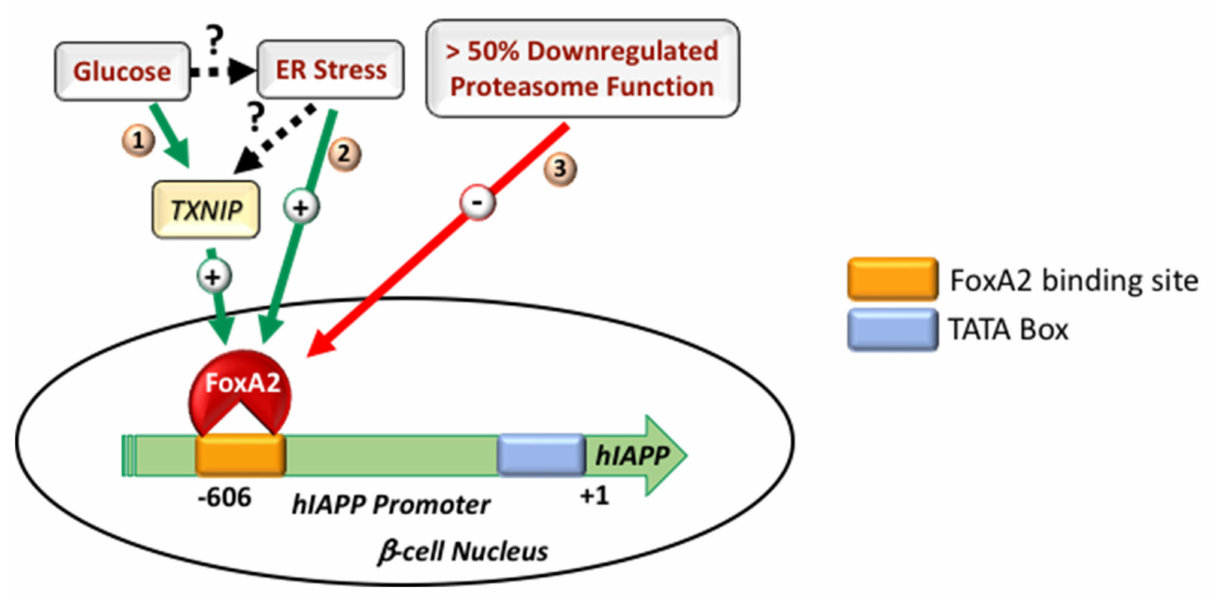
Figure 2. Regulatory mechanisms driving IAPP transcription in normal and stressed pancreatic β -cells. ( 1 ) High glucose induces expression of the major glucose regulated gene TXNIP, which, in turn, upregulates IAPP transcription by increasing the expression and promoter binding of IAPP specific transcription factor FoxA2 in the β -cell. ( 2 ) Similarly, ER stress upregulates IAPP transcription in β -cells by increasing IAPP promoter’s occupancy for transcription factor FoxA2, for which the binding of could be TXNIP-dependent or independent. ( 3 ) Severe inhibition of proteasome function and associated protein stress downregulate IAPP transcription by attenuating FoxA2 binding at the IAPP promoter in the β -cell. Green arrows depict positive regulatory pathways, and red arrow depicts an inhibitory pathway. Different signaling branches are numbered. Dashed arrows depict hypothetical signaling